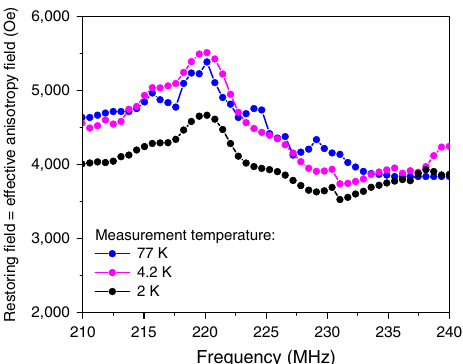
Figure 6 | Example of effective anisotropy field obtained from the measurement of the FNR spectra. Effective anisotropy measured at 77 (black), 4.2 (magenta) and 2K (blue). No significant variation of the effective anisotropy can be observed with the